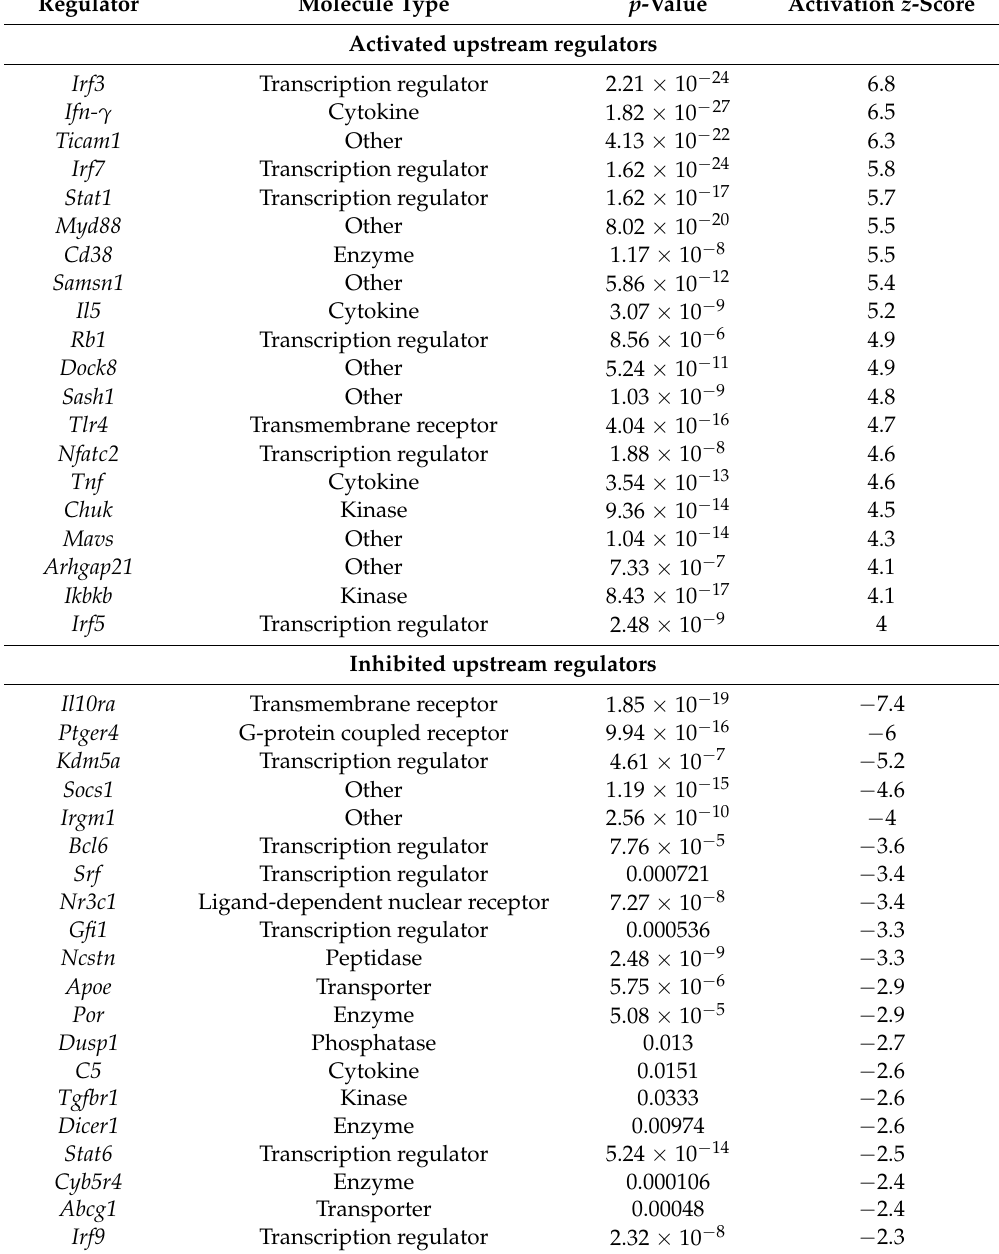
Table 2. List of the top 20 upstream regulators activated or inhibited during in vivo R. conorii